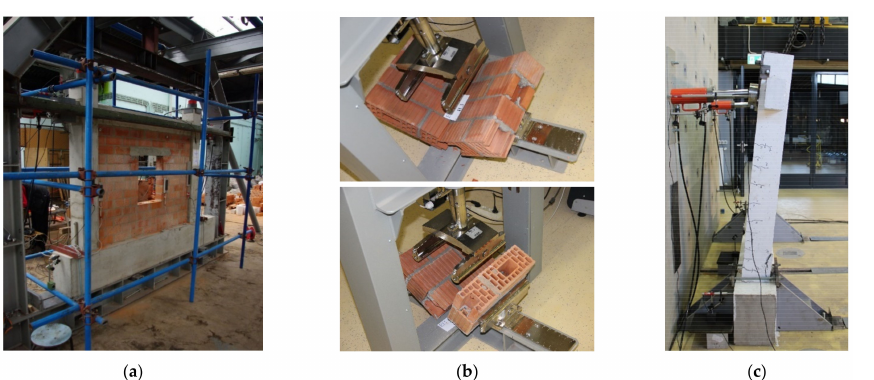
Figure 2. Photographs of conducted test series. ( a ) IP tests on a frame with infill wall and [5]; ( b ) OoP